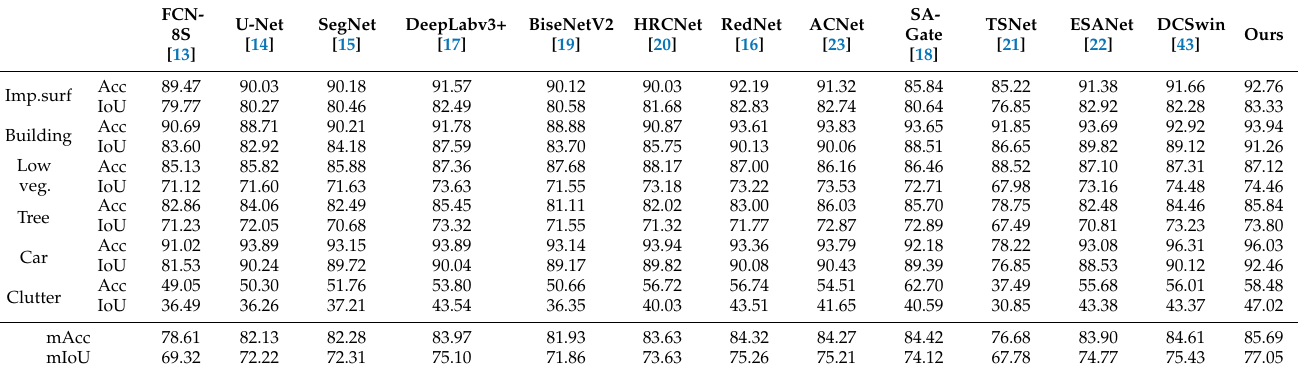
Table 2. Quantitative results of the proposed DGPRNet and 11 state-of-the-art methods on the Potsdam